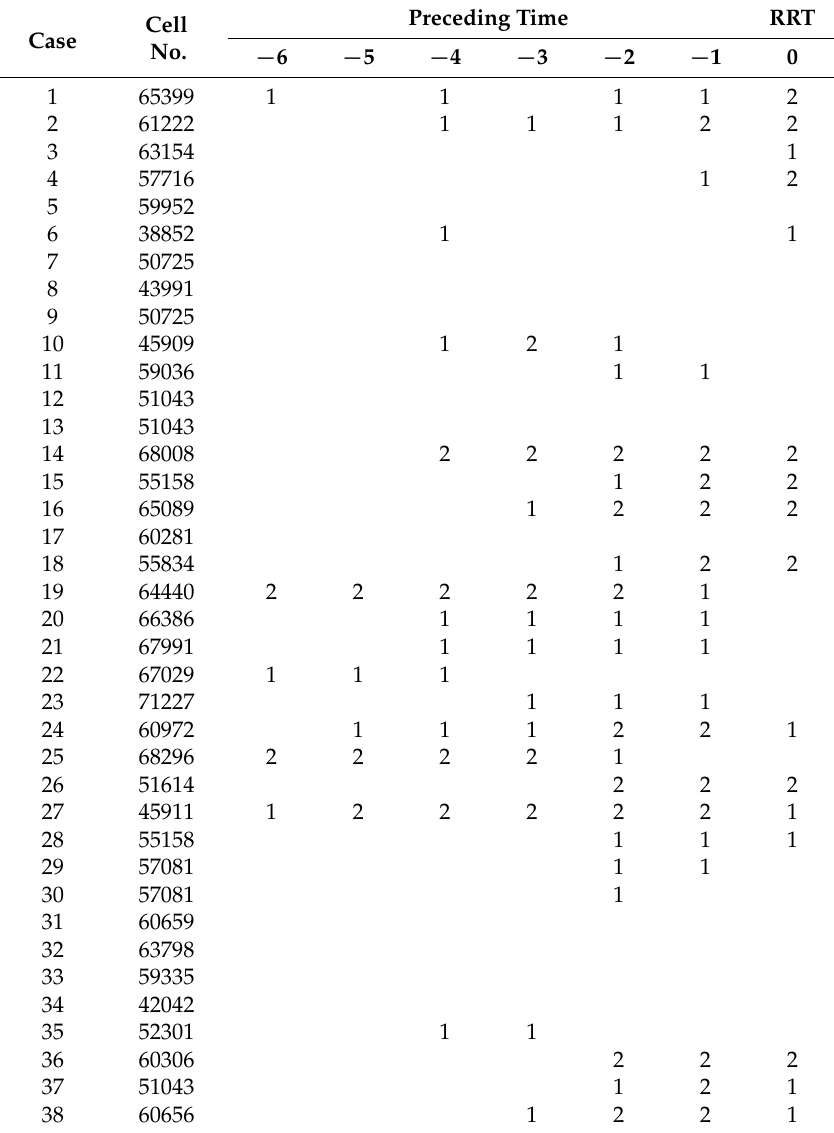
Table 6. Flash flood risk index for cells during preceding time based on rescue request time (RRT) corresponding to rescue request locations, where 1 is Flash Flood Watch and 2 is Flash Flood Warning. The first column lists the flash flooding cases shown in Table 1 and the second column lists the cells corresponding to the